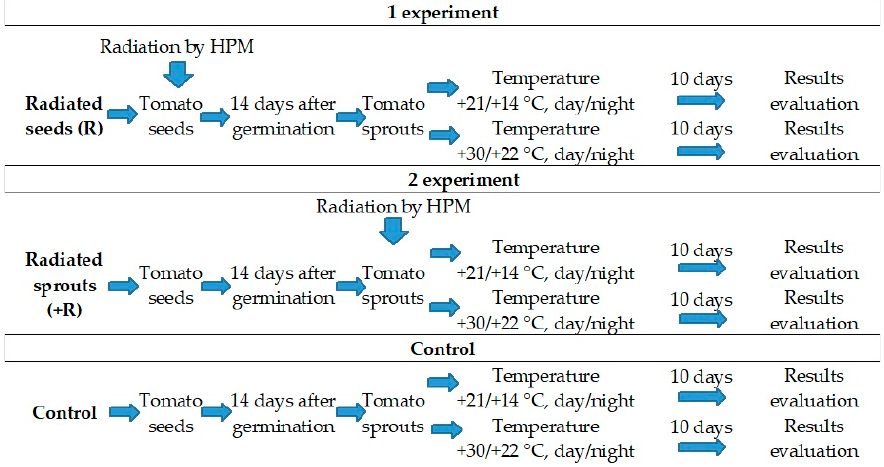
Figure 2. Experimental